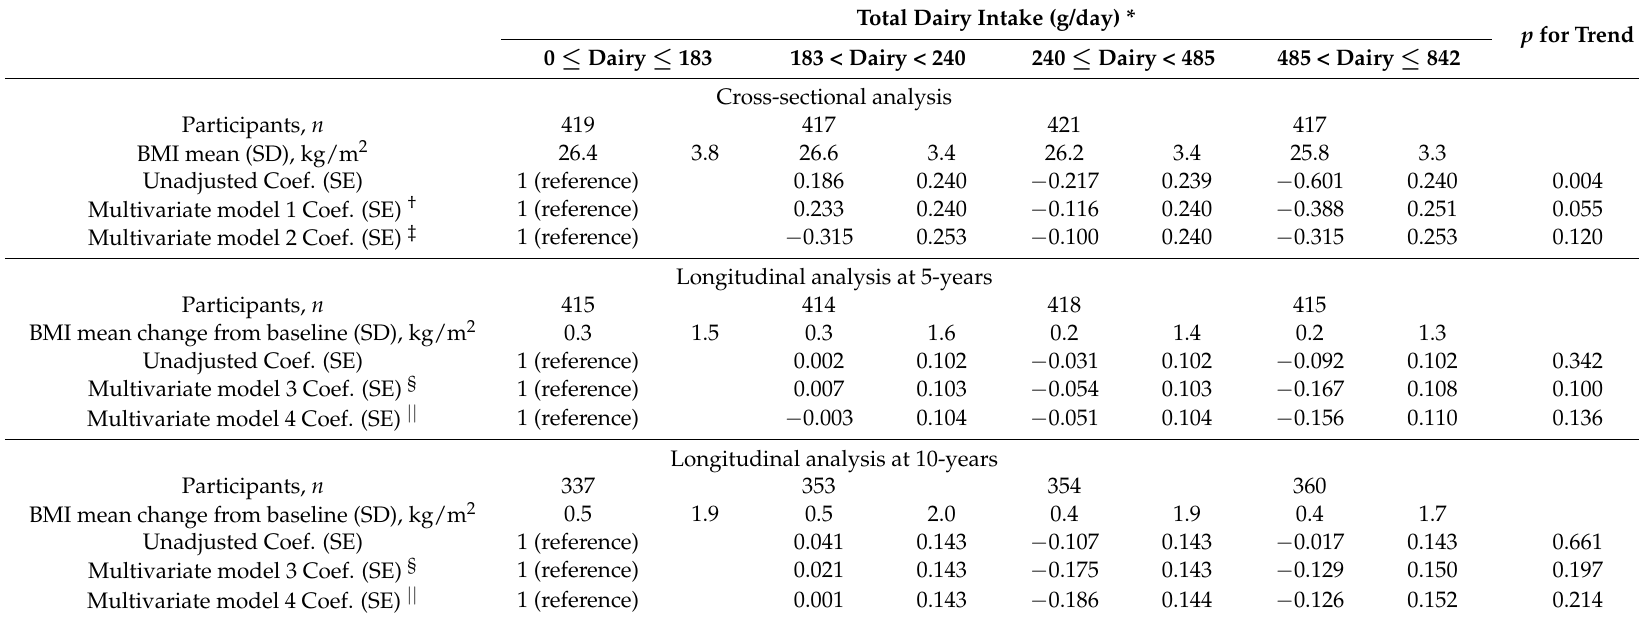
Table 2. Cross-sectional analysis of body mass index (BMI) at baseline and longitudinal analyses over 10-year of BMI changes from baseline by quartile of total dairy